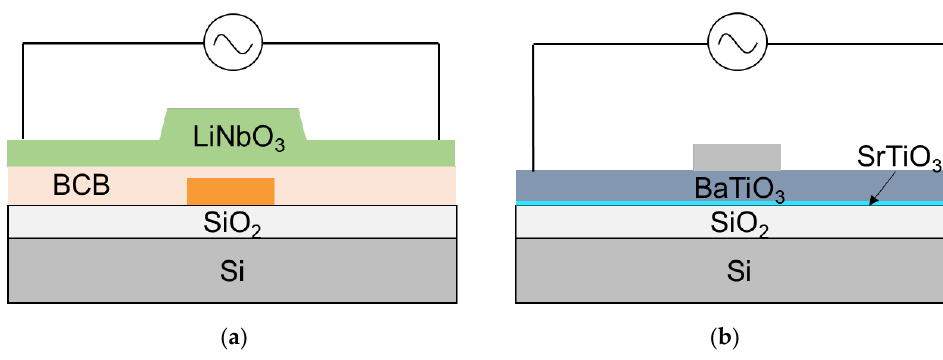
Figure 6. ( a ) Schematic cross-sections of ( a ) LN/Si optical phase shifter [73] and ( b ) BTO/Si optical phase shifter using Pockels effect [75].